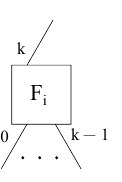
Figure 5. A generic fog node layout for the hub and spoke mode within the framework proposed.